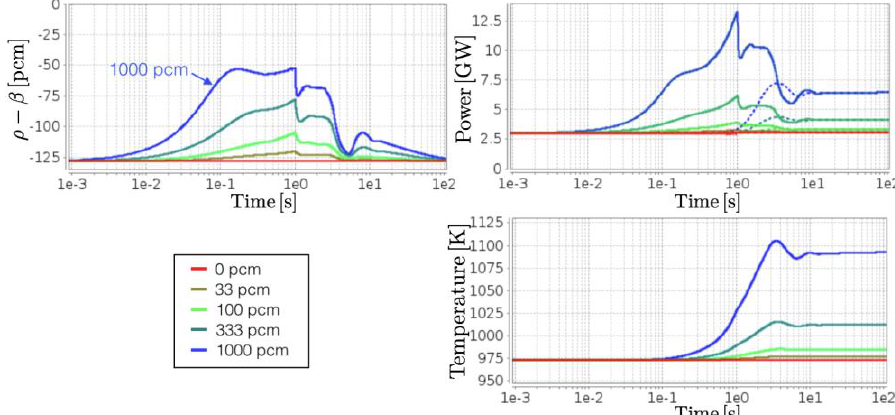
Figure 2. Transients of reactivity insertion in one second simulated with